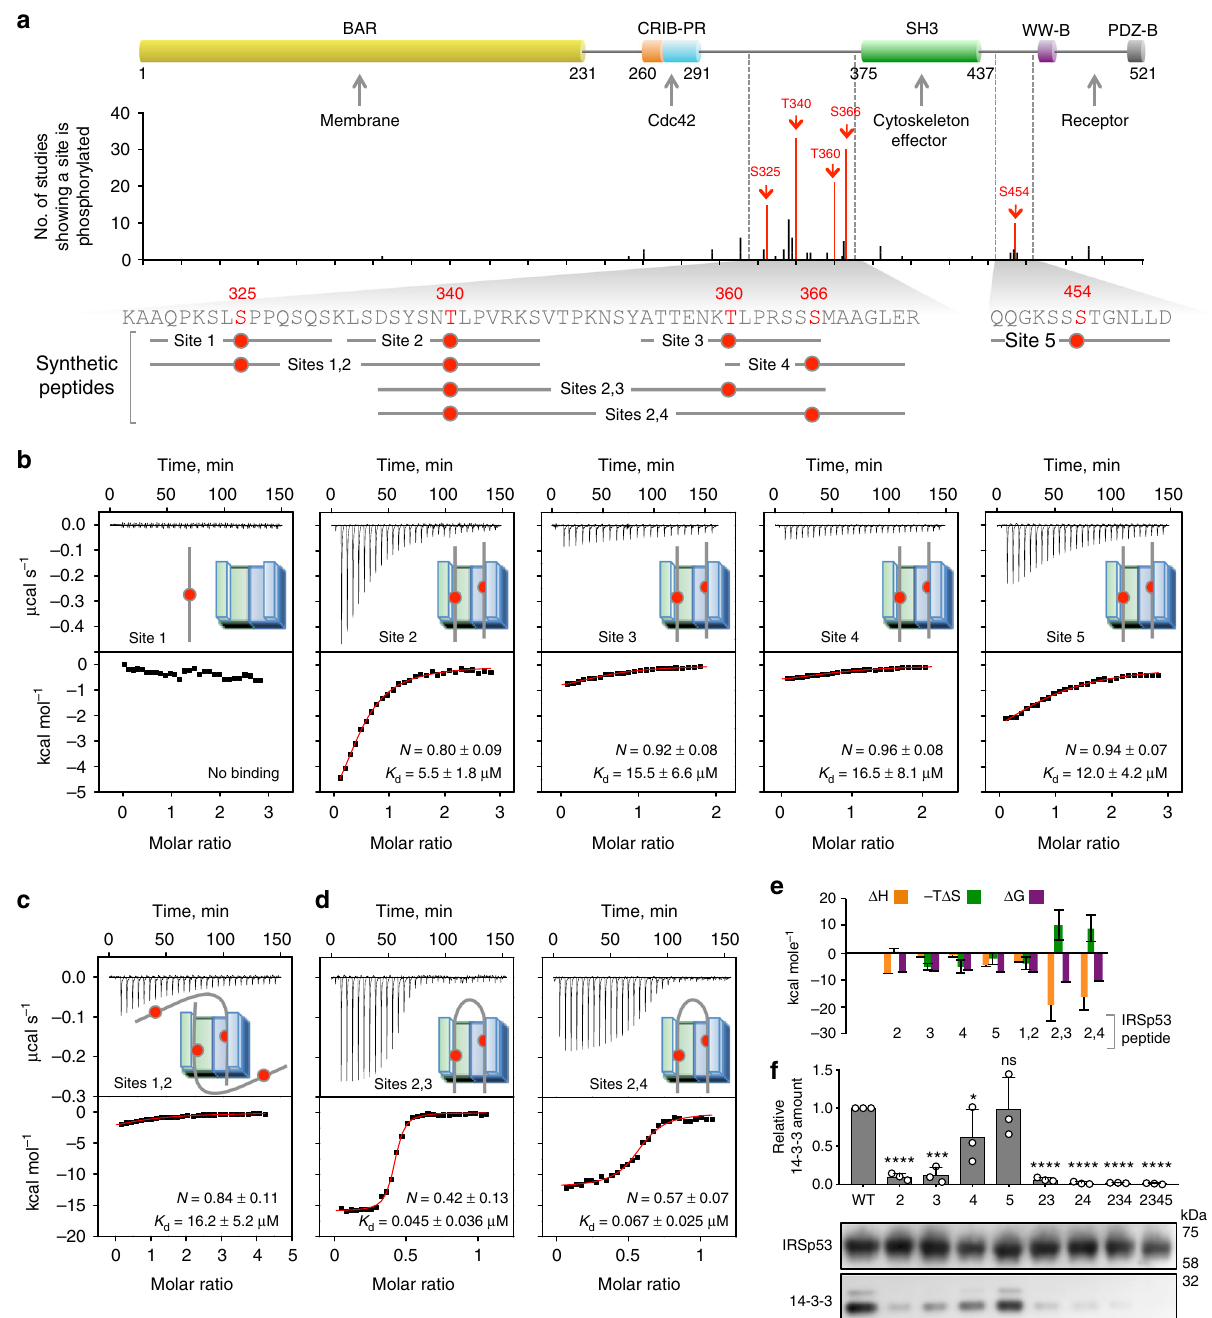
Fig. 2 Characterization of the 14-3-3-binding sites of pIRSp53. a Domain organization of IRSp53, showing the location of phosphorylation sites and the de fi nition of synthetic phospho-peptides used in this study. In the graph, the height of each phosphorylation site represents the number of times a particular residue has been found to be phosphorylated in phosphoproteomics studies curated by PhosphoSitePlus (www.phosphosite.org). Among these, fi ve sites (highlighted red) were consistently found to be phosphorylated in four different pIRSp53 samples analyzed here (puri fi ed as shown in Fig. 1). Note that the fi ve sites identi fi ed here coincide with the highest frequency sites in PhosphoSitePlus. b – d ITC titrations of 100 μ M singly phosphorylated (Site 1 to 5) or 50 μ M doubly-phosphorylated (Sites 1,2; 2,3 and 2,4) peptides into 10 μ M 14-3-3 θ (as indicated). ITC experiments were performed at 20 °C. Listed for each experiment are the dissociation constant ( K d ) and binding stoichiometry ( N ) derived from fi tting of the binding isotherm (red line). Errors correspond to the s.d. of the fi ts. e Change in thermodynamic parameters Δ H (orange bars), -T Δ S (green bars), and Δ G (purple bars), derived from the fi ts of the ITC titrations shown in panels b – d . Errors correspond to the s.d. of the fi ts. f Coimmunoprecipitation of 14-3-3 with WT IRSp53-FLAG and mutants carrying S/T- > A substitutions of the indicated phosphorylation sites (named according to the number of the fi ve major phosphorylation sites shown in part a ). Abundance is reported relative to the amount of endogenous 14-3-3 that coimmunoprecipitates with WT IRSp53-FLAG in serum-starved cells ( fi rst column). Error bars are ± s.d. from three independent experiments, shown as open circles. The statistical signi fi cance of the measurements was determined using an unpaired two-sided Student ’ s t -test, comparing each of the mutants to WT IRSp53 (ns, non-signi fi cant; * p < 0.05; *** p < 0.001; **** p <